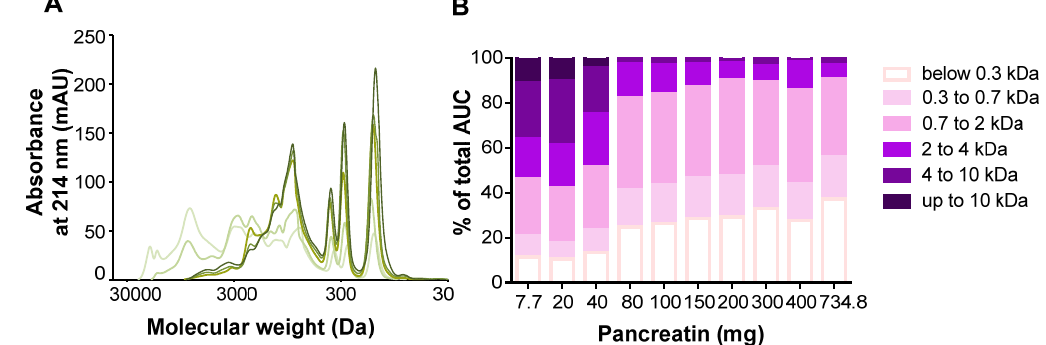
Figure 1. Molecular weight profiles and distributions of W intestinal digests: optimization of the static gastrointestinal digestion (SGID). ( A ) Peptide profiles were obtained by size exclusion chromatography-fast protein liquid chromatography (SEC-FPLC): 7.7, 20, 200, 400, and 734.8 mg of pancreatin (light to dark green curves). ( B ) The apparent molecular weight distribution of peptides, expressed in percentage of total area under the curve (AUC), was calculated from the linear regression relationship, which correlates the Log of known molecular weight standard peptides and the elution volume.